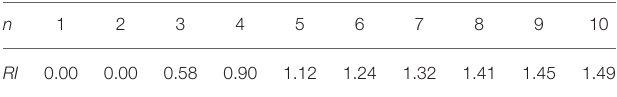
TABLE 3 | Random Index (RI) values for small